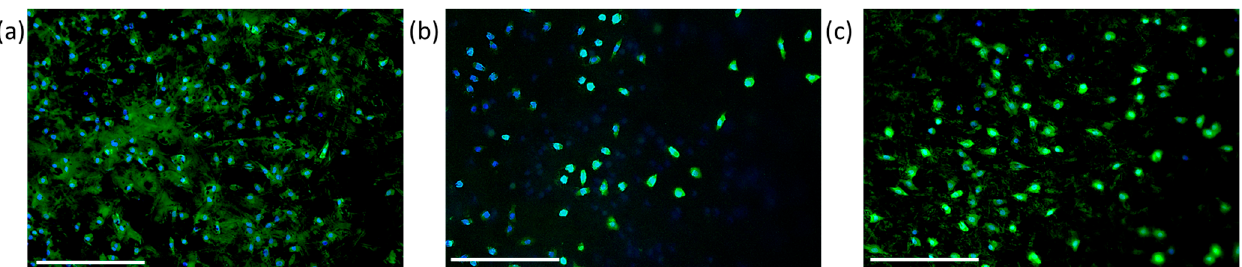
Figure 6. Confocal microscopy of L929 cells’ adhesion after 24 h, onto electrospun fibers of PVDF- TrFE loaded with P3HT ( a ), MB ( b ), and CuPc ( c ). The images (Scale bar: 250 µm) were obtained by staining cells via Cell-Tracker Green CMFDA.